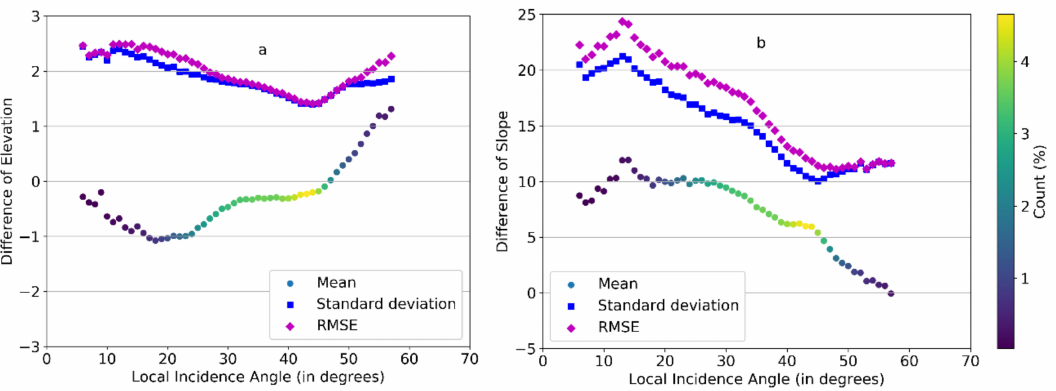
Figure 10. Relation between local incidence angle and difference of elevation ( a ) and difference of slope ( b ). The mean value is represented using dots, whose color indicates the percentage of DTM points used to calculate the mean and standard deviation (see color bar on the right side).